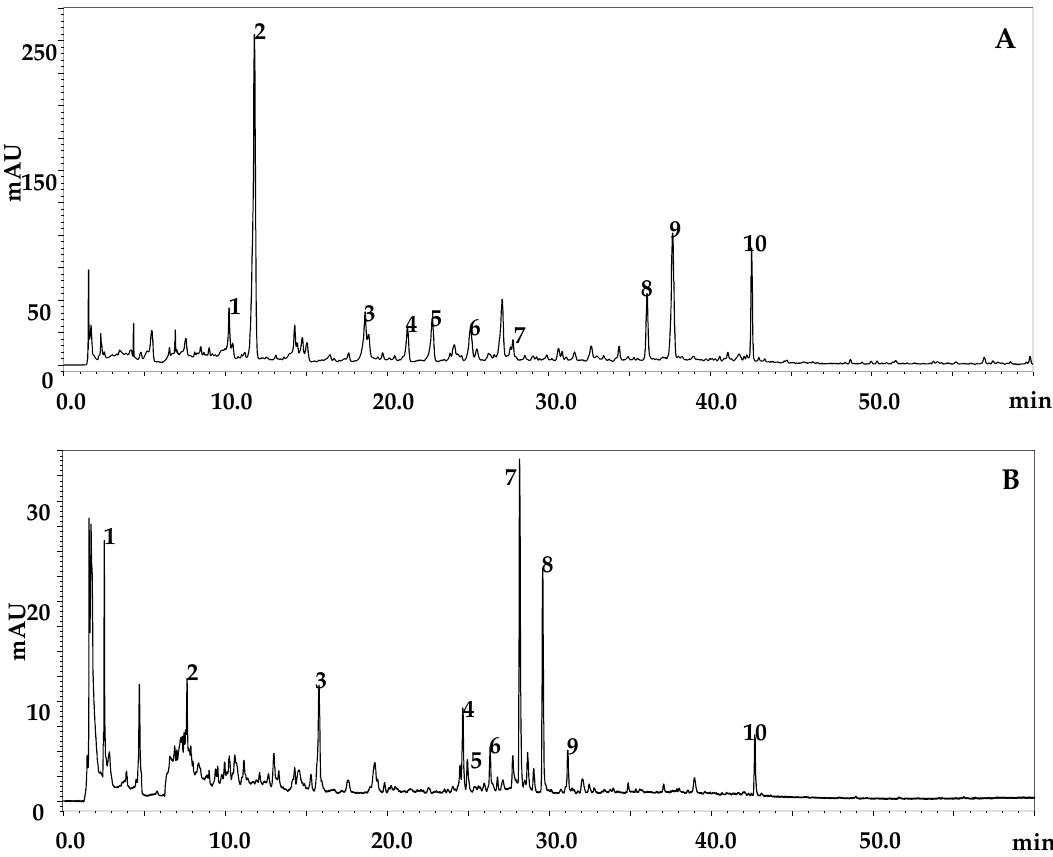
Figure 2. Polyphenolic profiles of Z. lotus extracts obtained by HPLC-PDA-ESI / MS analysis at λ = 280 nm: ( A ) EtOAc, ( B ) MeOH-H 2